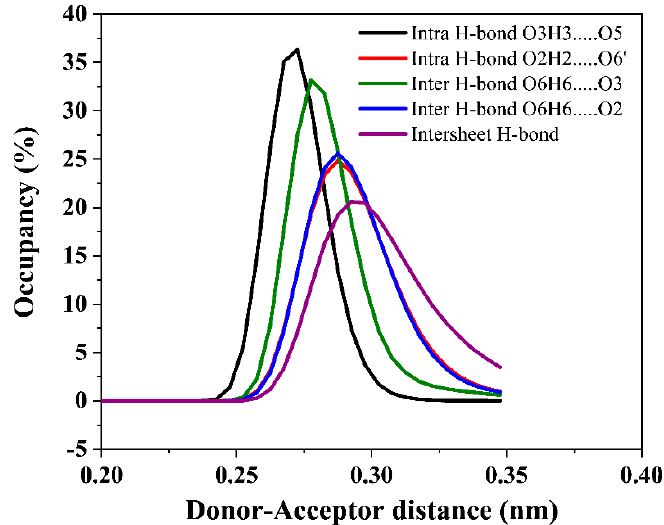
Figure 5. The donor-acceptor distance and occupancy of hydrogen bonds with an electric field along the z-axis. Table 2. The hydrogen bond formation distance between the donor and acceptor atoms of cellulose and their occupancy under an external electric field (electric field along the z-axis).